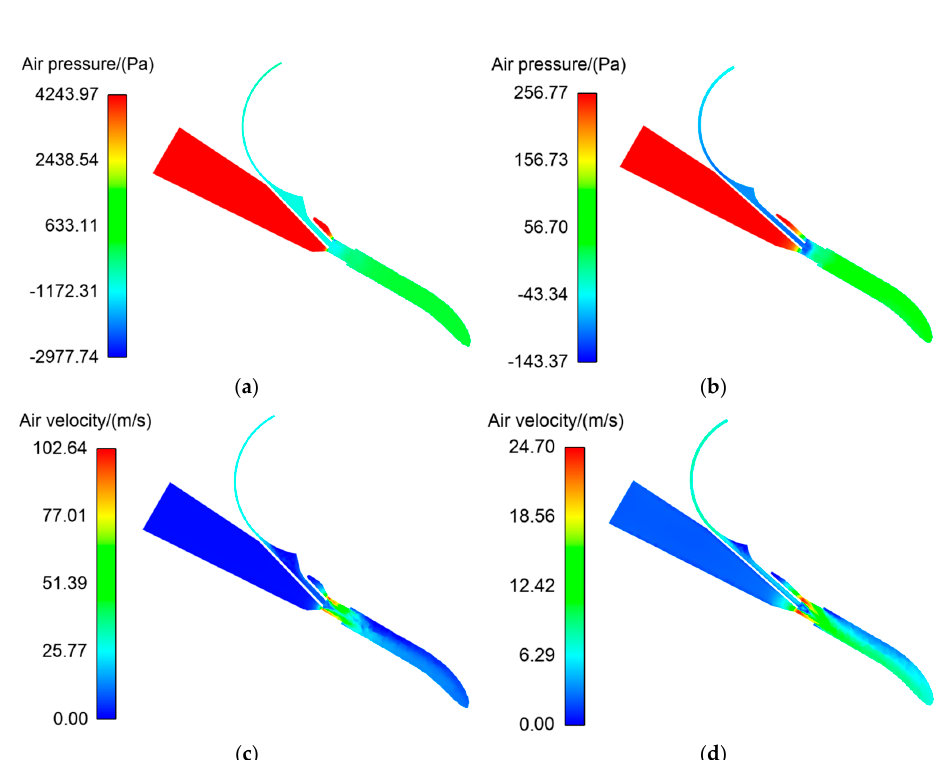
Figure 10. Velocity and pressure of airflow field of distribution manifold: ( a ) air pressure distribution in test 3; ( b ) air pressure distribution in optimal result; ( c ) air velocity distribution in test 3; ( d ) air velocity distribution in optimal result.